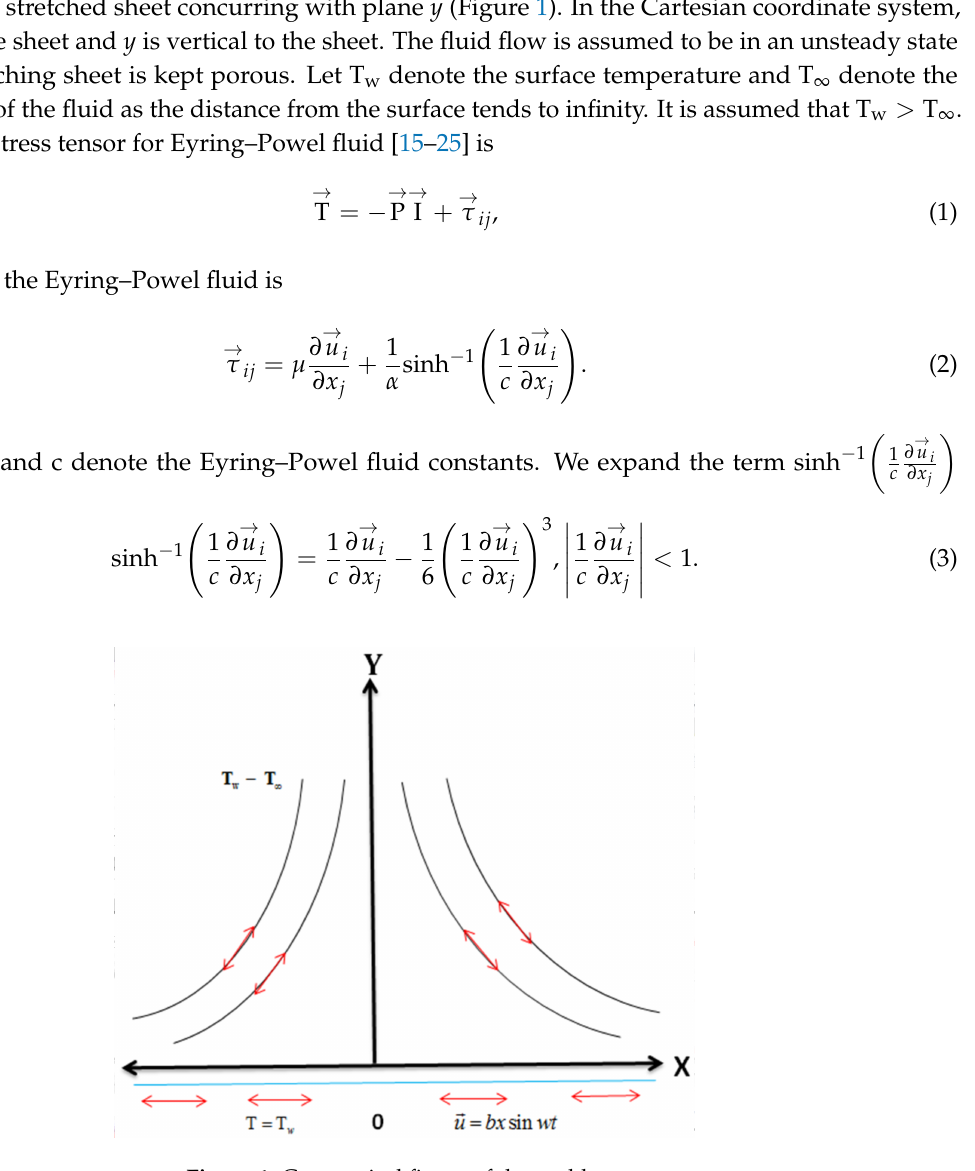
Figure 1. Geometrical figure of the